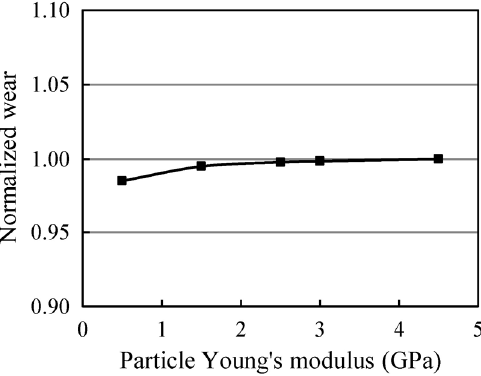
Fig. 9 Variations of the wear versus the surface Young’s modulus ( 10  ° and the other variables are at the reference values).